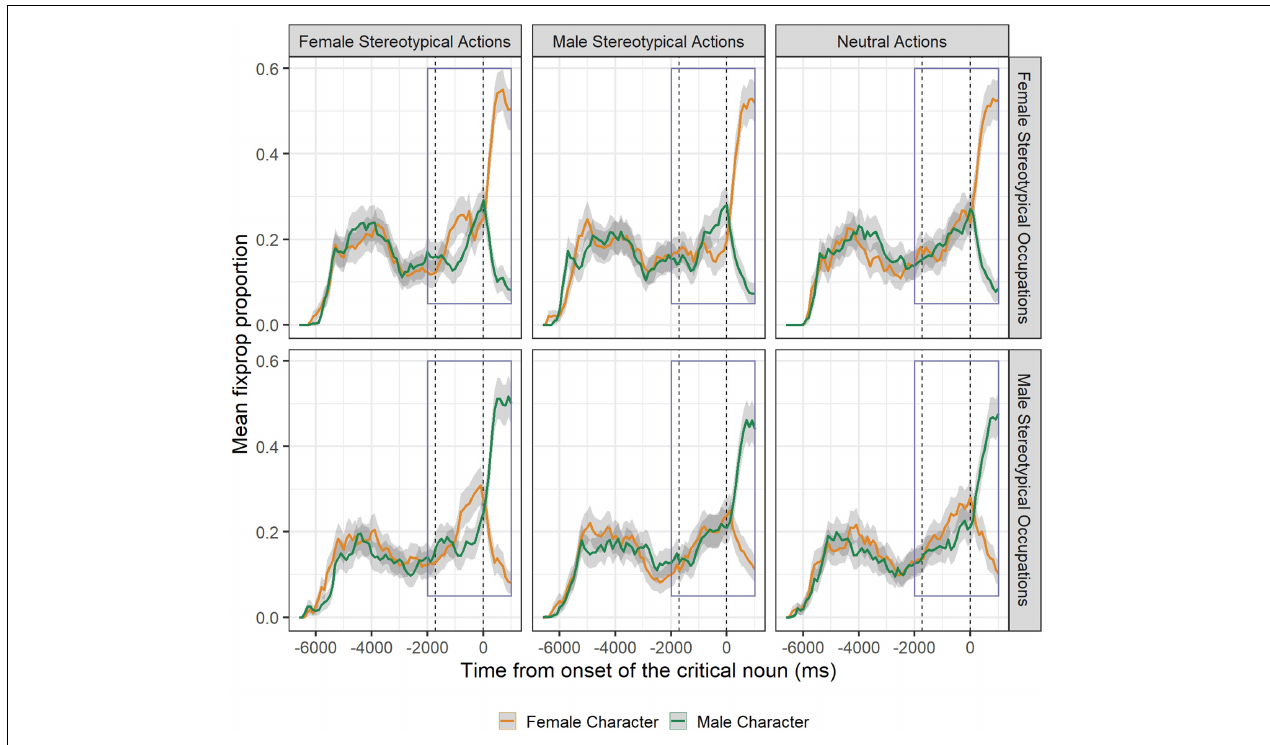
FIGURE 2 | Mean proportion of fixation in all experimental conditions. In all panels, orange lines represent proportion of fixations toward the female character, and green lines represent fixations toward the male character. Gray areas around the main lines represent corresponding 95% CIs adjusted for within-subject designs. The first vertical dashed line represents average onset of the critical verb, and the second line marks the exact onset of the critical noun. The purple squares within the figures mark the window of